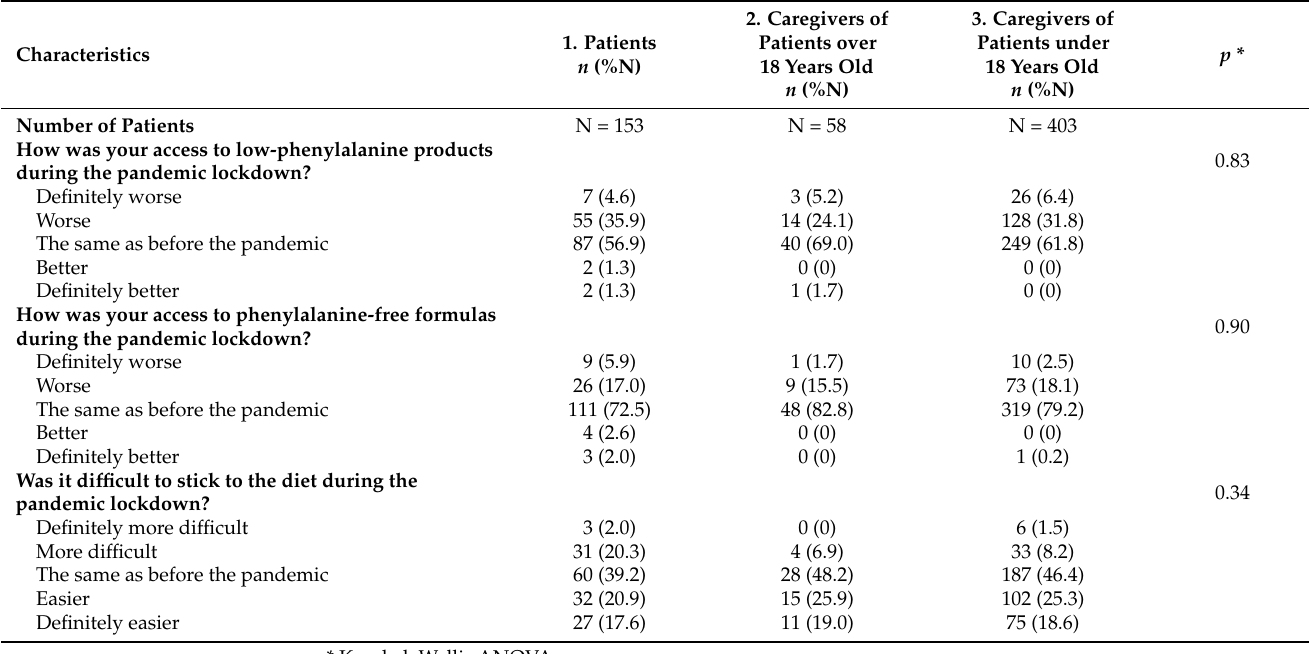
Table 3. The views of respondents on availability of special food and their opinion on being on the diet during the pandemic lockdown.